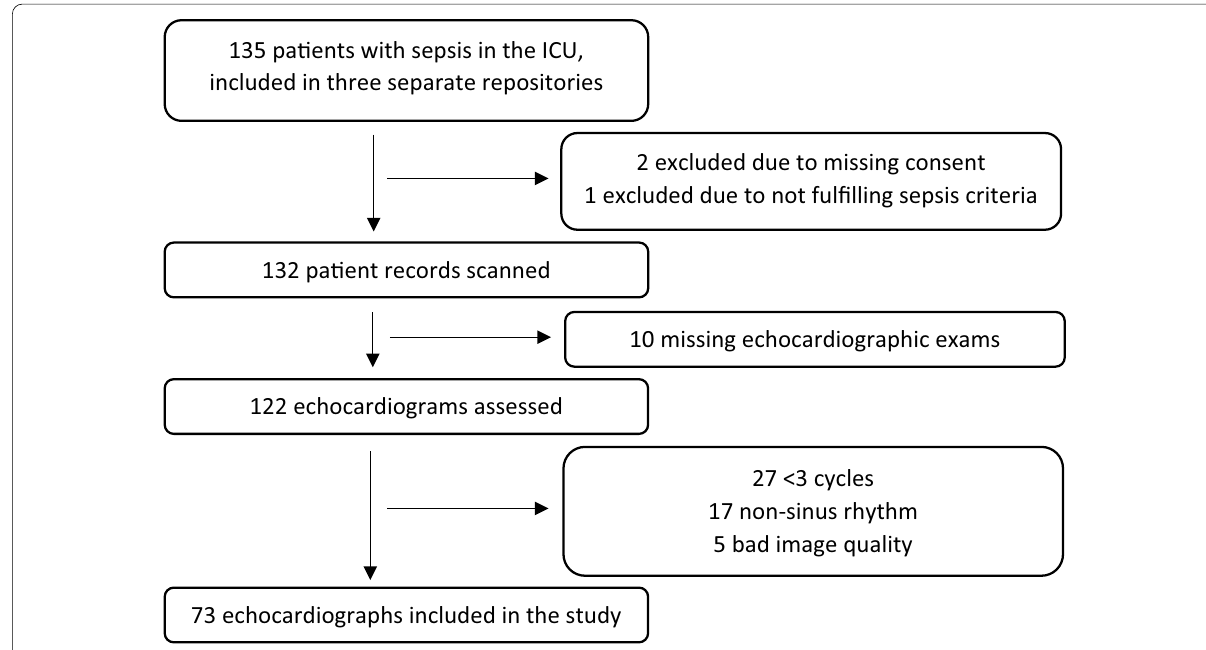
Fig. 2 Flowchart showing details of included and excluded studies